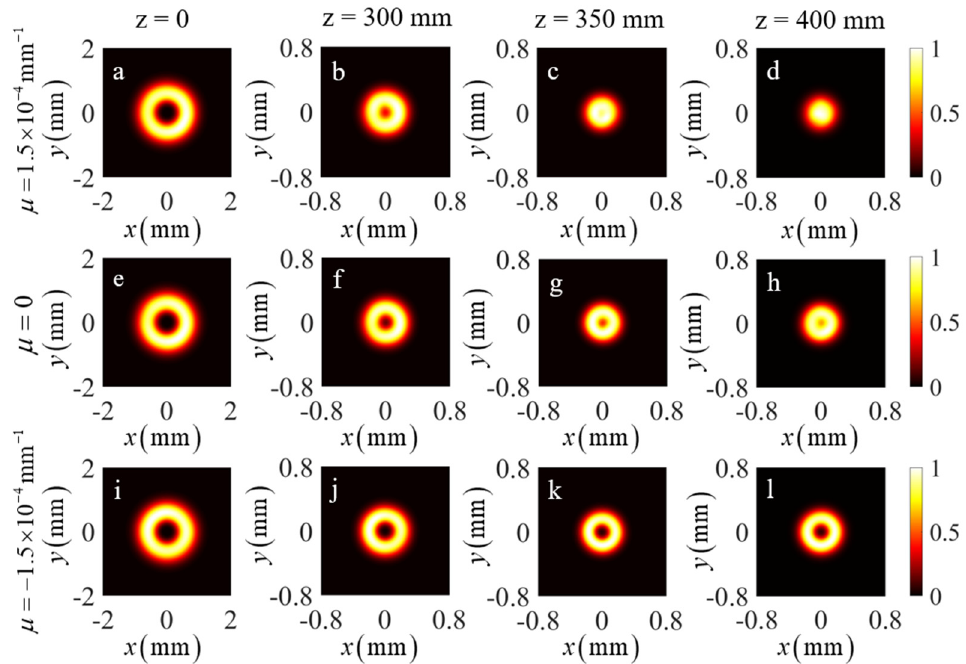
Figure 4. The simulation results for the spectral density at different propagation distances of a TLGSM beam with ( a – d ) the twist factor µ = 1.5 × 10 − 4 mm − 1 , ( e – h ) µ = 0, and ( i – l ) µ = − 1.5 × 10 − 4 mm − 1 .